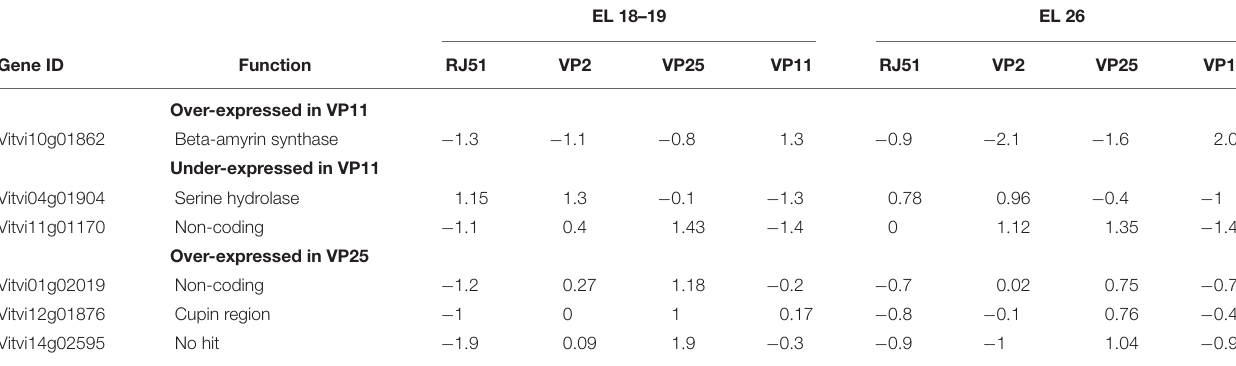
TABLE 5 | List of genes with differential expression stable over stages between one loose vs. the other in RNAseq